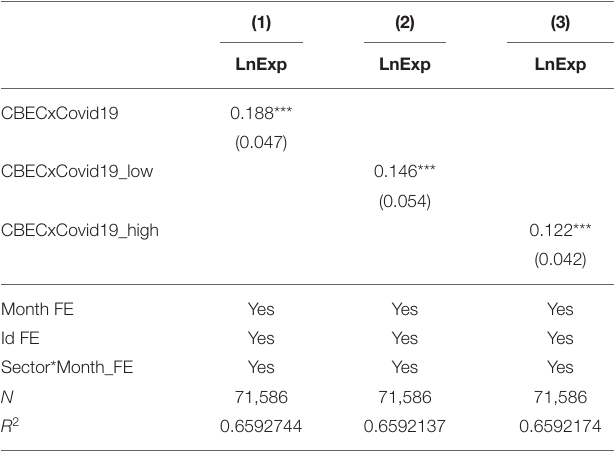
TABLE 4 | Regression results of the robustness test based on